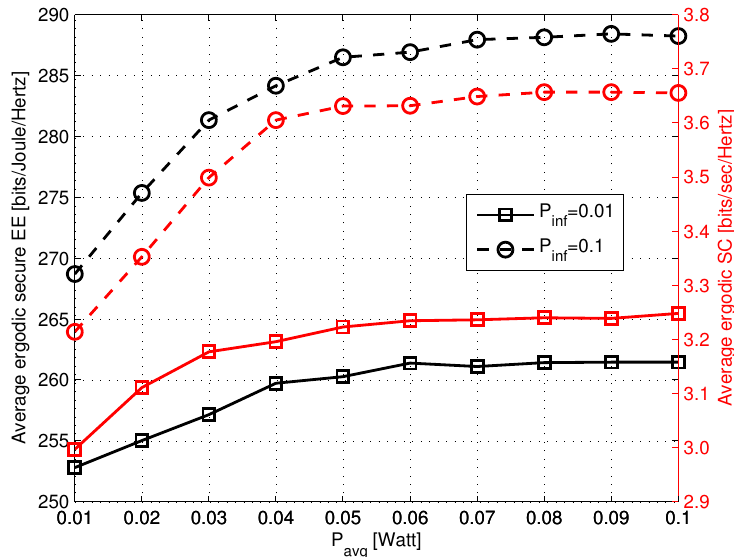
Figure 4. Average ergodic secure EE and SC of SU versus P avg